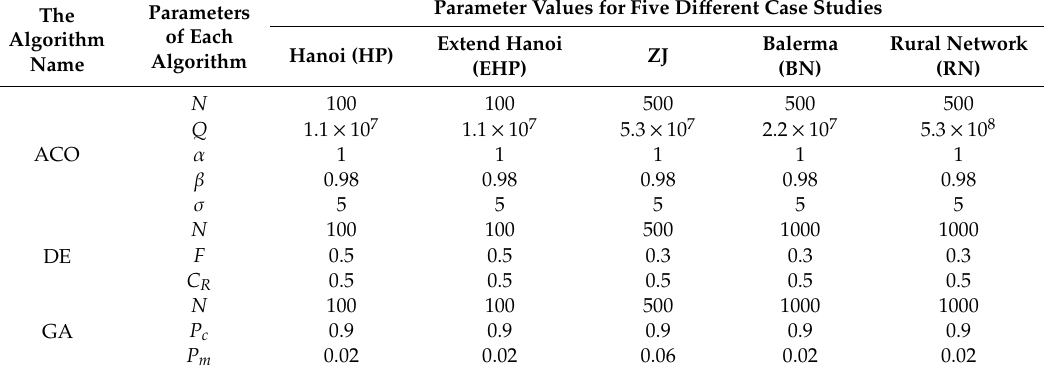
Table 1. Details of the parameterization strategies of the EAs applied to the five case studies. Parameters are as follows: where N is the population size, P c and CR are the crossover probabilities for the GA and DE respectively, P m and F are their mutation probabilities; α = pheromone weighting factor; β = visibility weighting factor; ρ = pheromone decay factor; Q = pheromone update coe ffi cient; N = number of ants; σ = number of elitist ants; Maximum number of allowed generations for each algorithm is 10,000. The